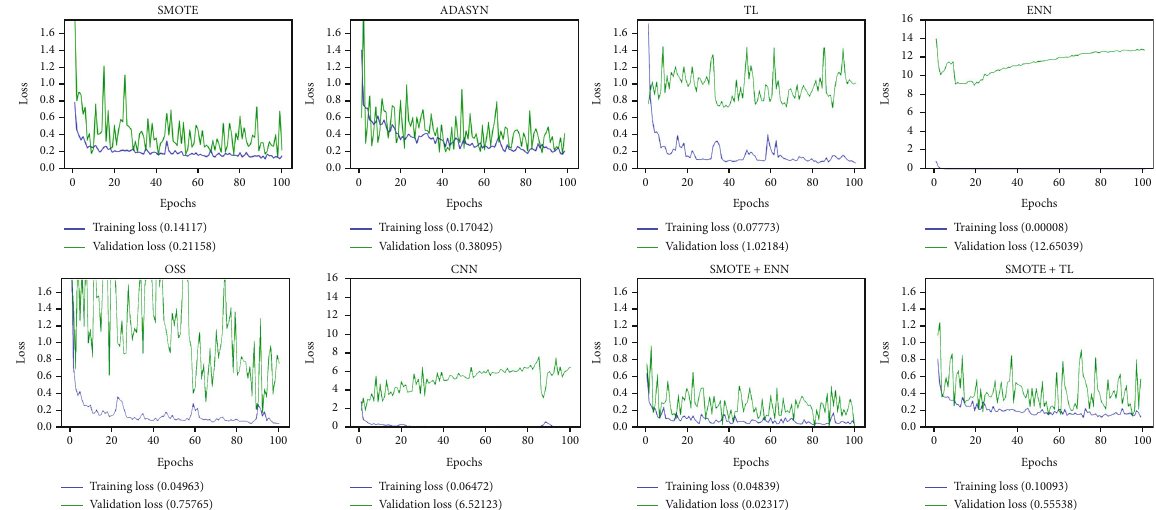
Figure 9: Training and validation loss versus epochs for each sampling